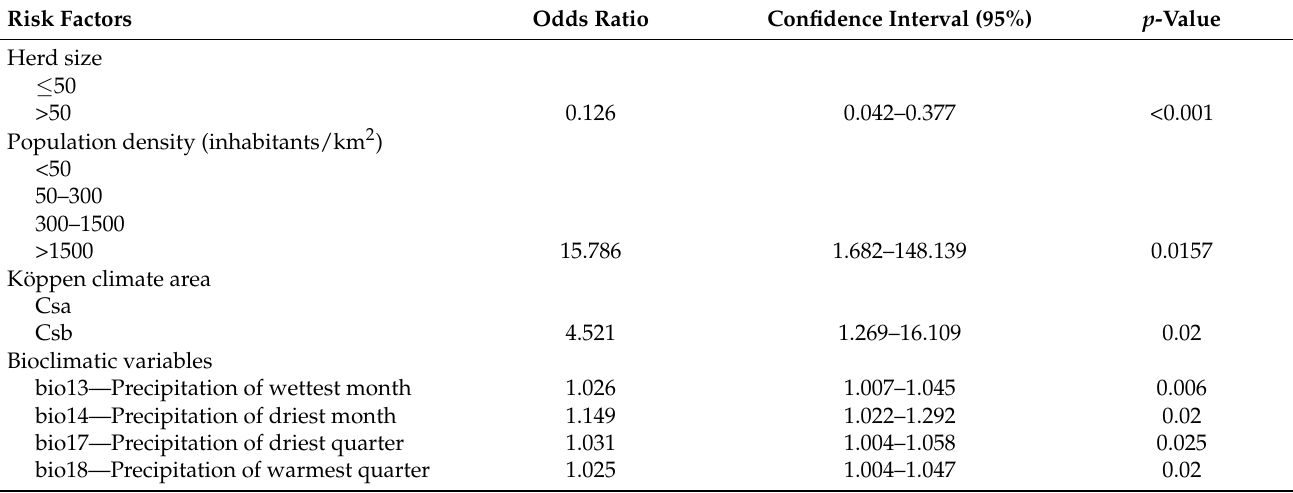
Table 3. Univariate GLMM results for Toxoplasma gondii seroprevalence. Farm ID was included as a random effects